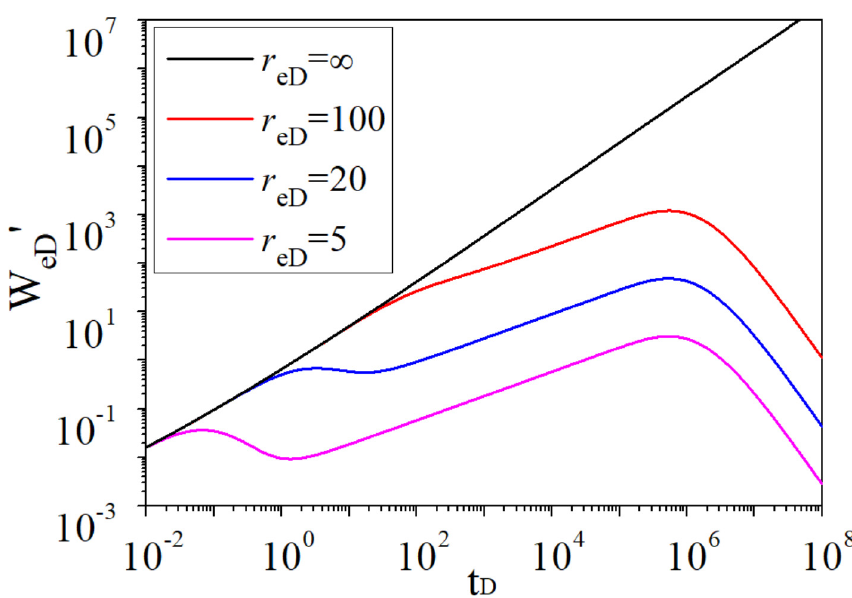
Figure 4. Dimensionless water influx curves of different r eD .